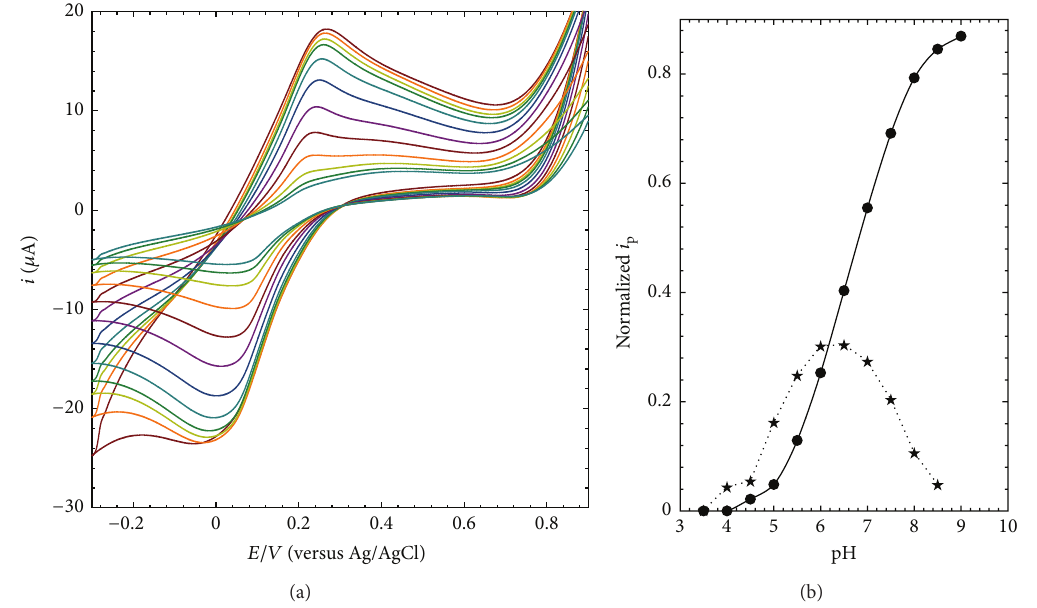
Figure 3: (a) The cyclic voltammograms obtained at the MCPE/MNP in 0.1M PBS containing 0.1M NaClO 4 in the presence of 0.5mM ] 3−/4− at different pH. Outer to inner; pH 2.5, 3.0, 4.1, 4.6, 5.0, 5.5, 6.0, 6.5, 7.0, 7.5, 8.0, 8.5, 9.0, and 9.5. (b) Faradaic current titration [ Fe ( CN ) 6 curve for the MCPE/MNP (solid line) and its first derivative (dotted line), normalized 𝑖